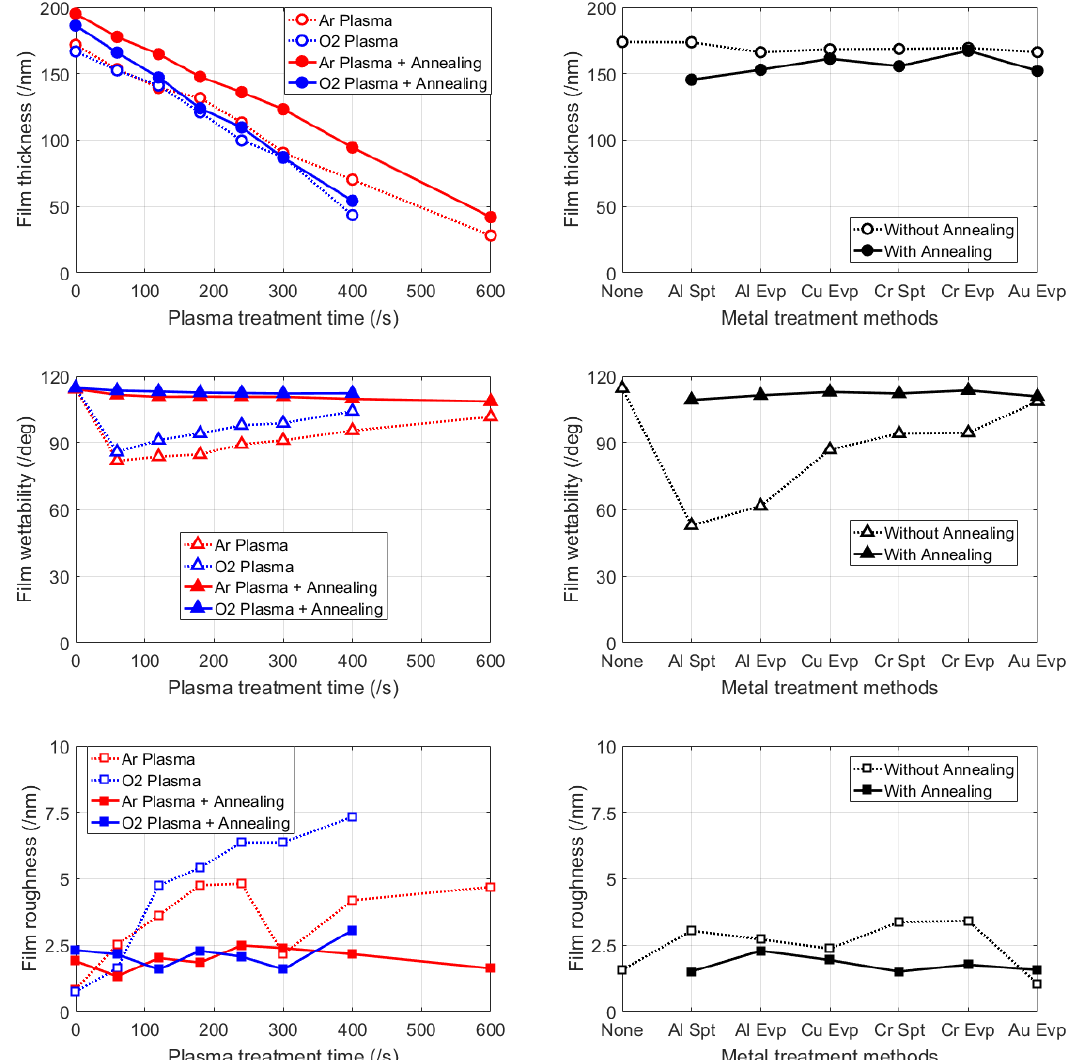
Figure 3. Experimental results. The upper-left chart shows the relationships between “Film thickness” and “Plasma treatment time” under four combinations of treatment conditions: “Ar Plasma” alone, “O 2 Plasma” alone, “Ar Plasma” plus “Annealing”, “O 2 Plasma” plus “Annealing”. The middle-left chart shows the relationships between “Film wettability” and “Plasma treatment time” under the same conditions. The lower-left chart shows the relationships between “Film roughness” and “Plasma treatment time” under the same conditions. The upper-right chart shows the relationships between “Film thickness” and “Metal treatment methods” under two conditions: without “Annealing”, with “Annealing”. The middle-right chart shows the relationships between “Film wettability” and “Metal treatment methods” under the same conditions. The lower-right chart shows the relationships between “Film roughness” and “Metal treatment methods” under the same